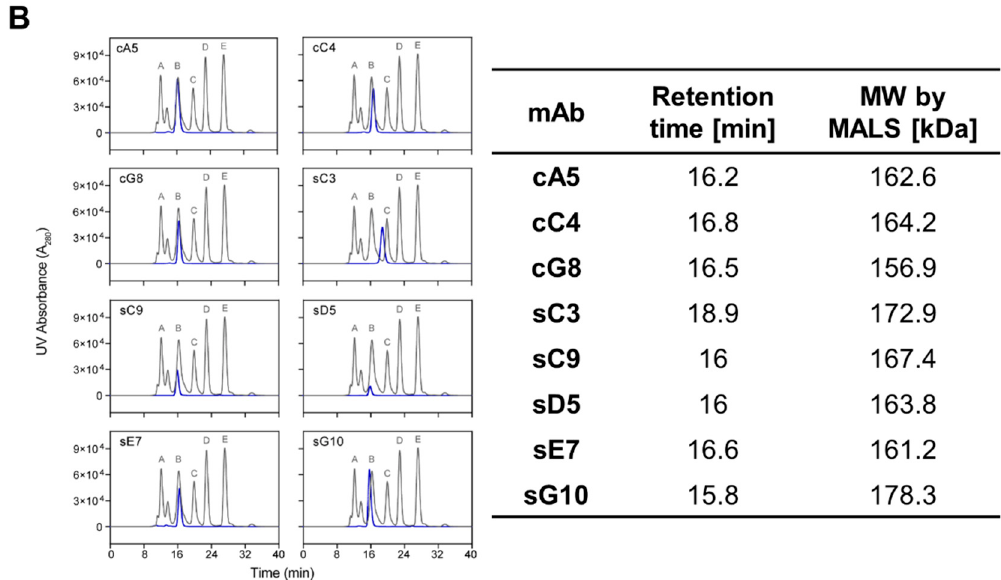
Figure 3. Analytical size exclusion chromatography (SEC) of purified anti-m β c mAbs. Chromatograms show the elution profile of each mAb (blue) overlayed on a standard run of proteins with known molecular weights (MW) (grey). ( A ) All 30 candidates eluted in a single peak indicative of a homogenous species of molecules in solution. However, six antibodies (cA5, cC4, cG8, sC3, sC9, and sE7) exhibited longer retention times than expected for a full-length IgG molecule when analyzed on a silica-based column. ( B ) These clones were further assessed on a Superdex 200 column coupled to a MALS detector for accurate MW determination. Retention times for all antibodies except sC3 were comparable to the IgG protein in the standard (peak B), and MWs corresponded with theoretically calculated values. Standard proteins: A—thyroglobulin (670 kDa), B—IgG (158 kDa), C—ovalbumin (44 kDa), D—myoglobin (17 kDa), E—vitamin E12 (1.35 kDa).